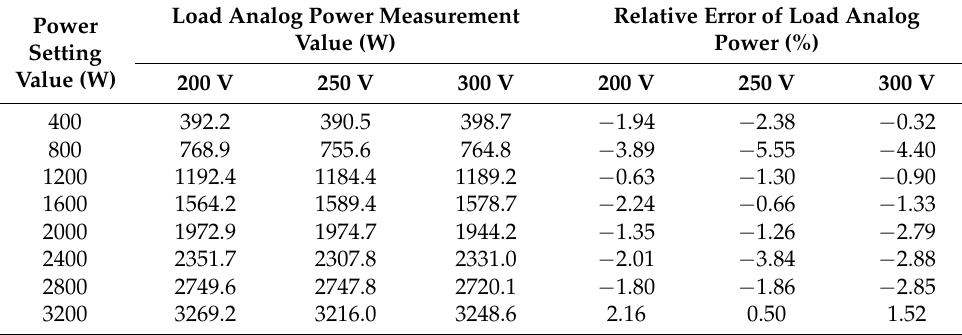
Table 4. Simulation accuracy test results of constant power load.